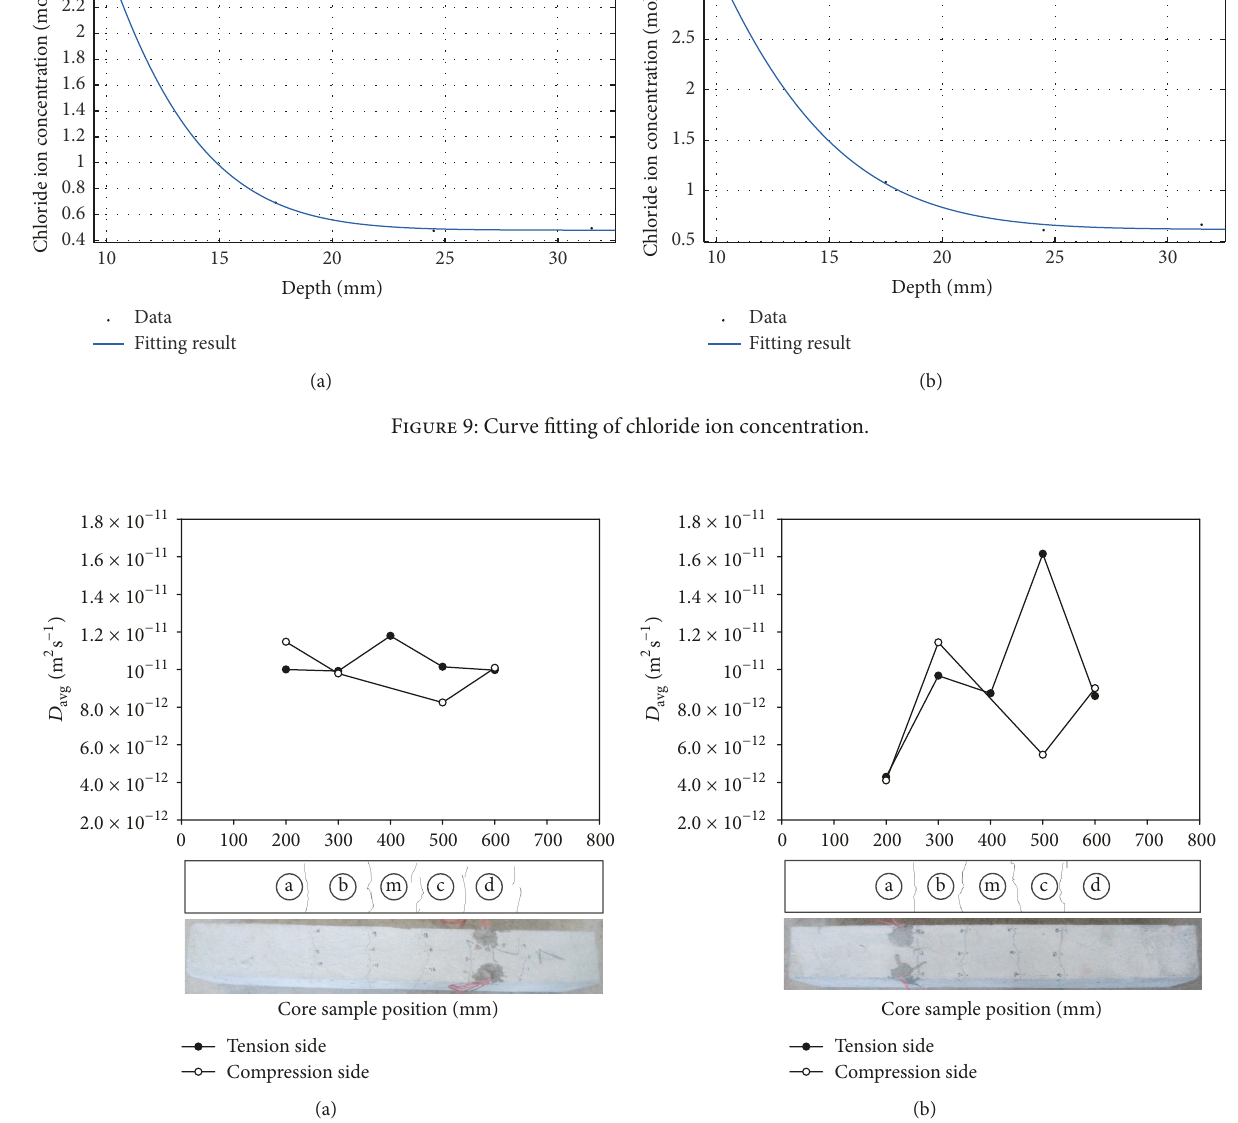
Figure 10: Average chloride diffusion coefficient in different core sample